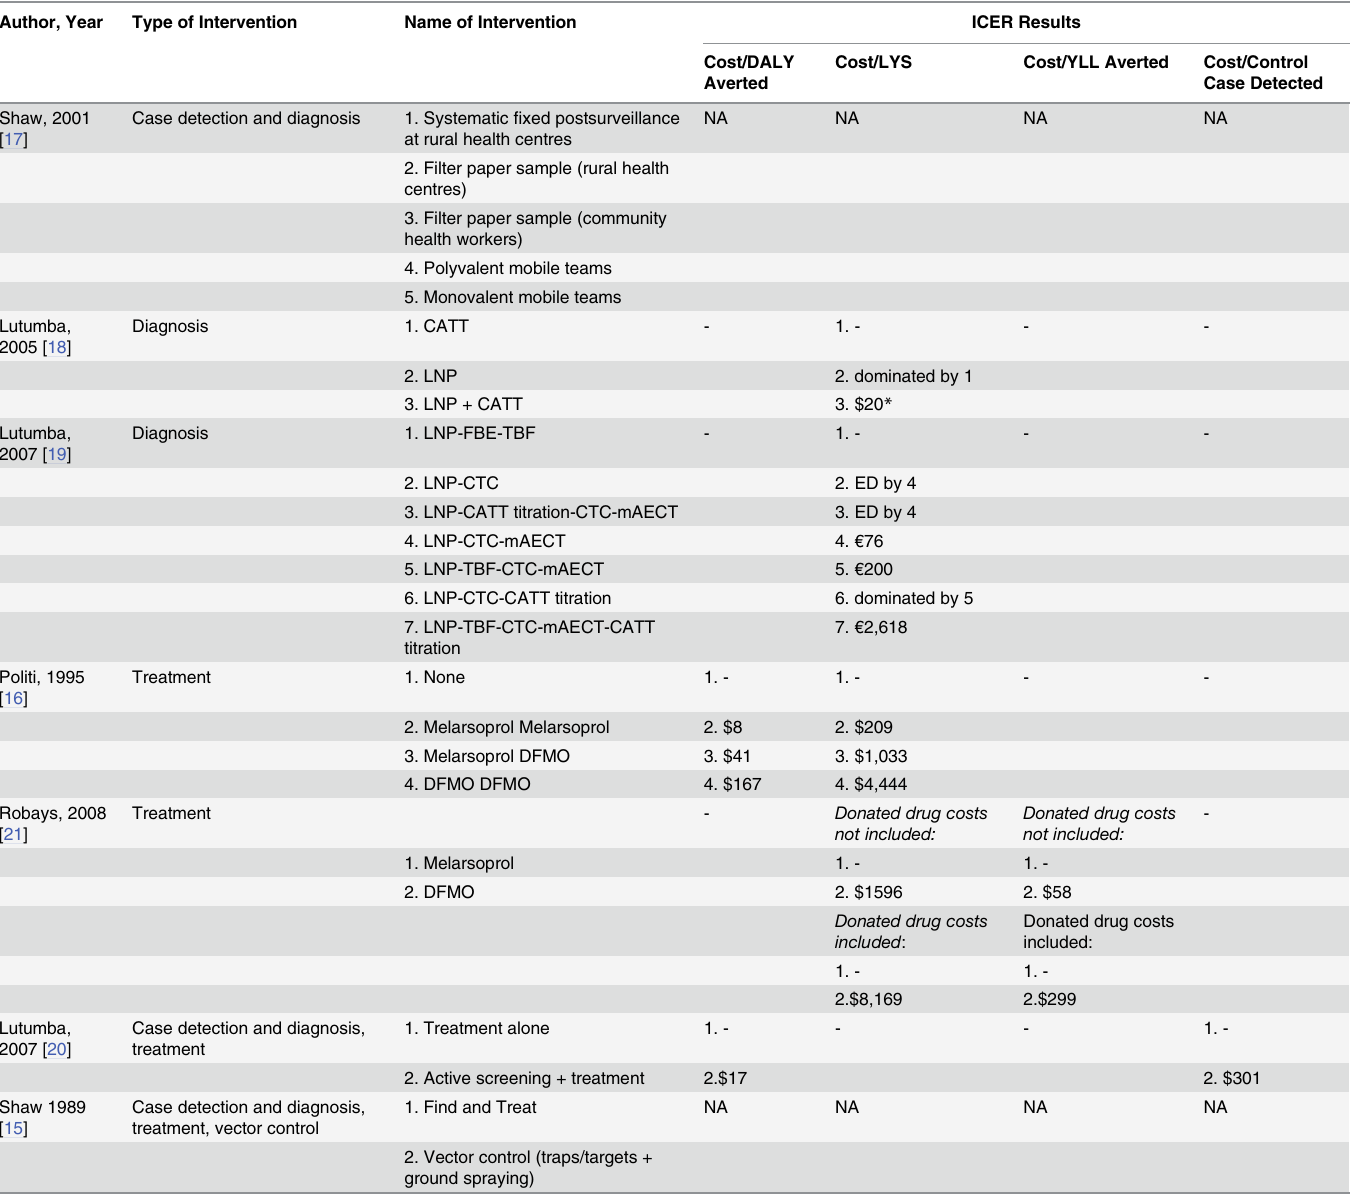
Table 5. ICER results from economic